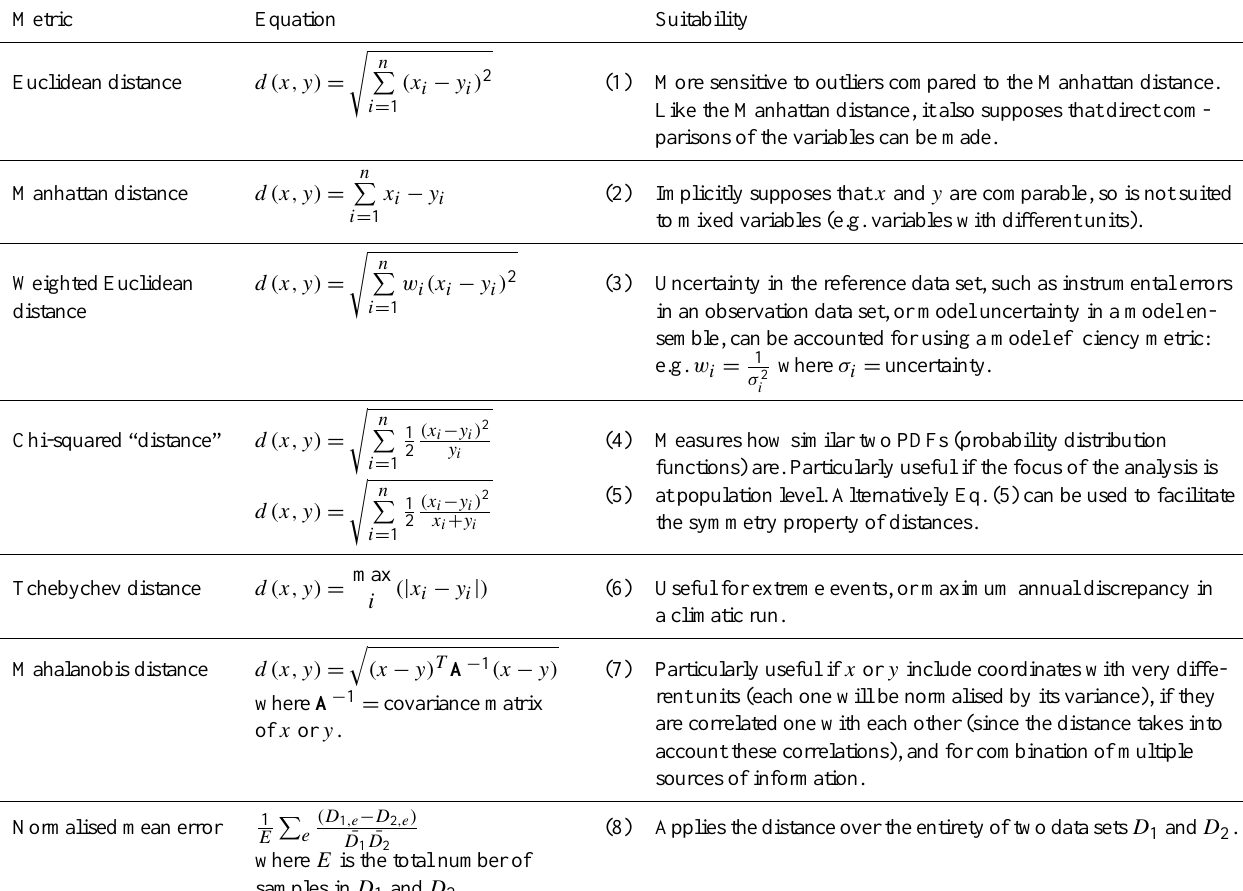
Table 2. Summary of Level 1 metrics ( x,y represent points while D 1 , D 2 are data sets). Metric Equation